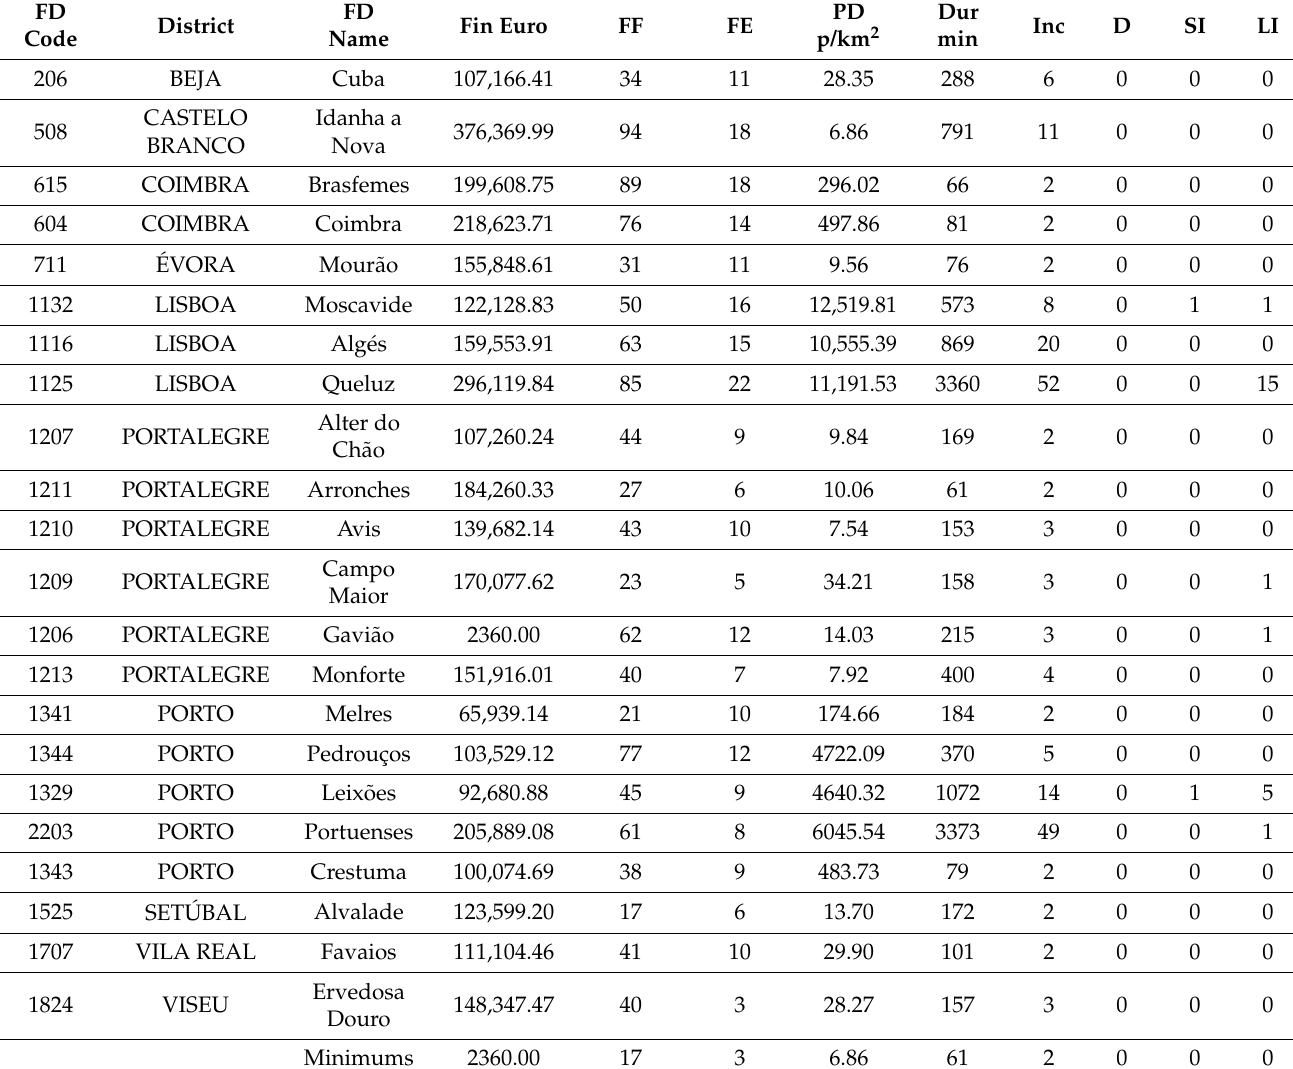
Table 3. Efficient Portuguese FDs in 2020 and their input–output values (Fin = financial budget, FF = number of firefighters, FE = number of fire engines, PD = population density, Dur = total incident durations, Inc = total incidents, D = number of deaths, SI = number of serious injuries, and LI = number of light